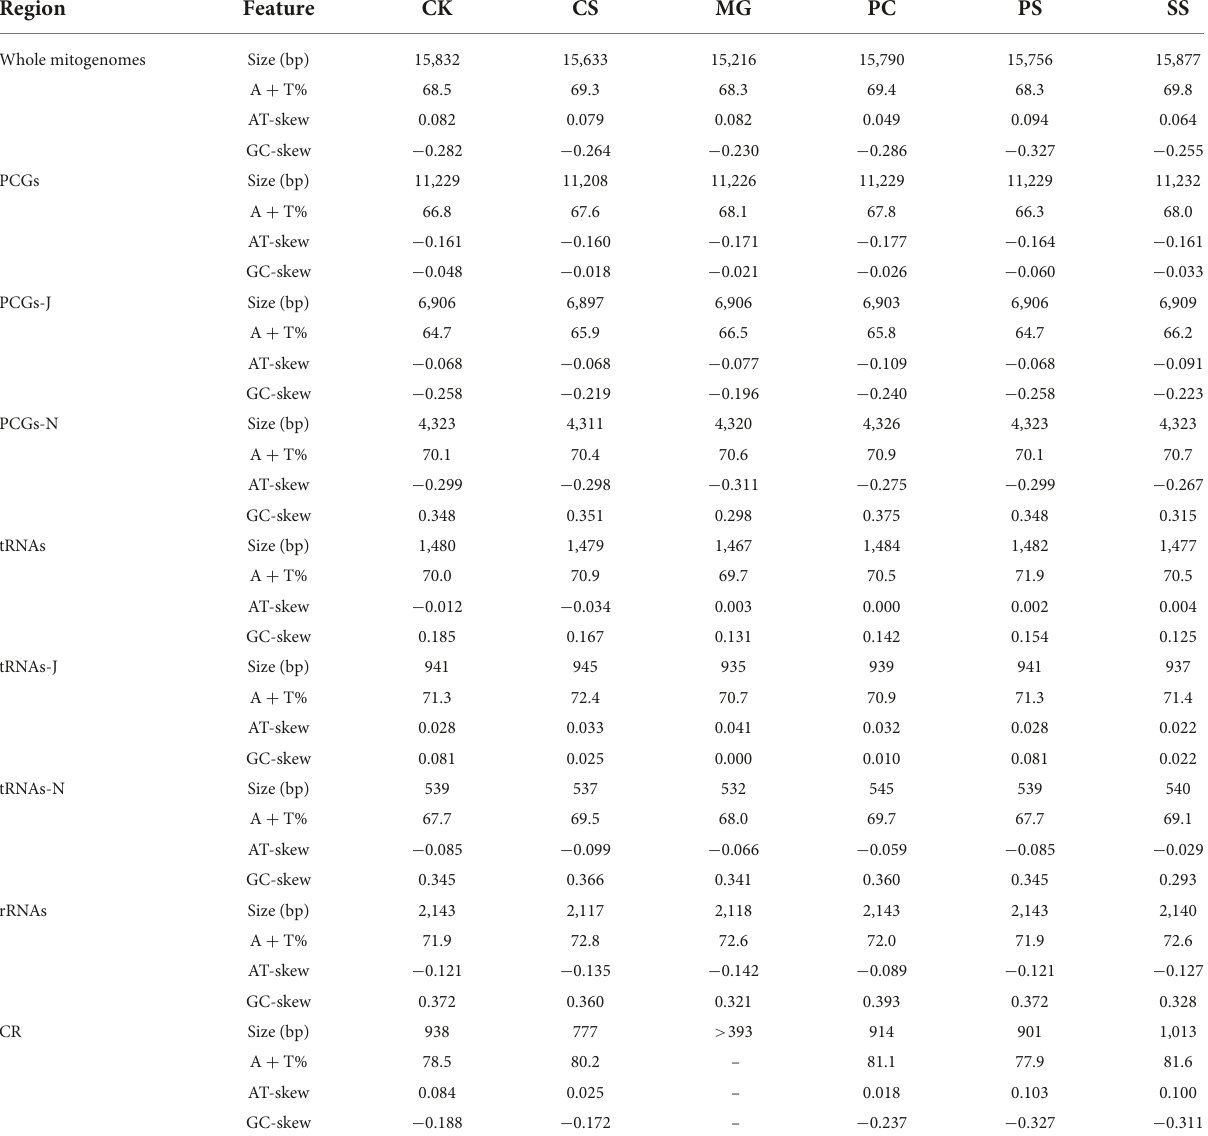
TABLE 2 Structural features of the mitochondrial genomes across six species of family Peltoperlidae. Region